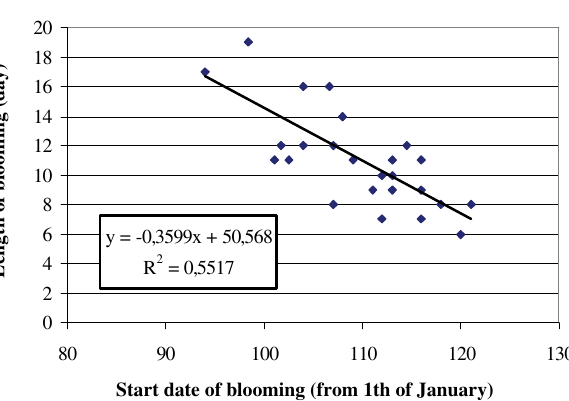
Figure 1. Relationship between the start date and length of blooming at ’Kántorjánosi’cultivar (Újfehértó 1983–2008)